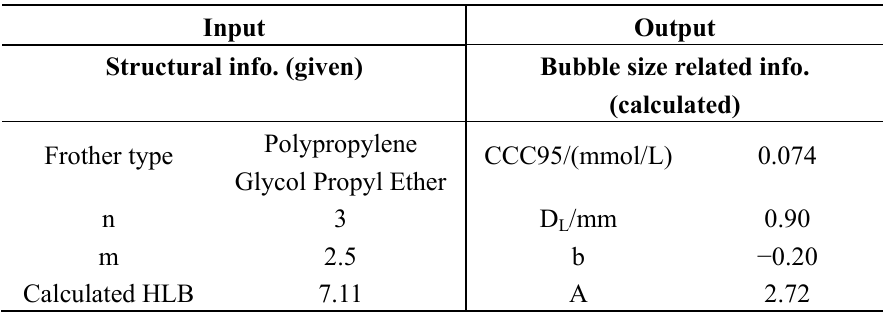
Table 6. D prediction for FX160-05. 32